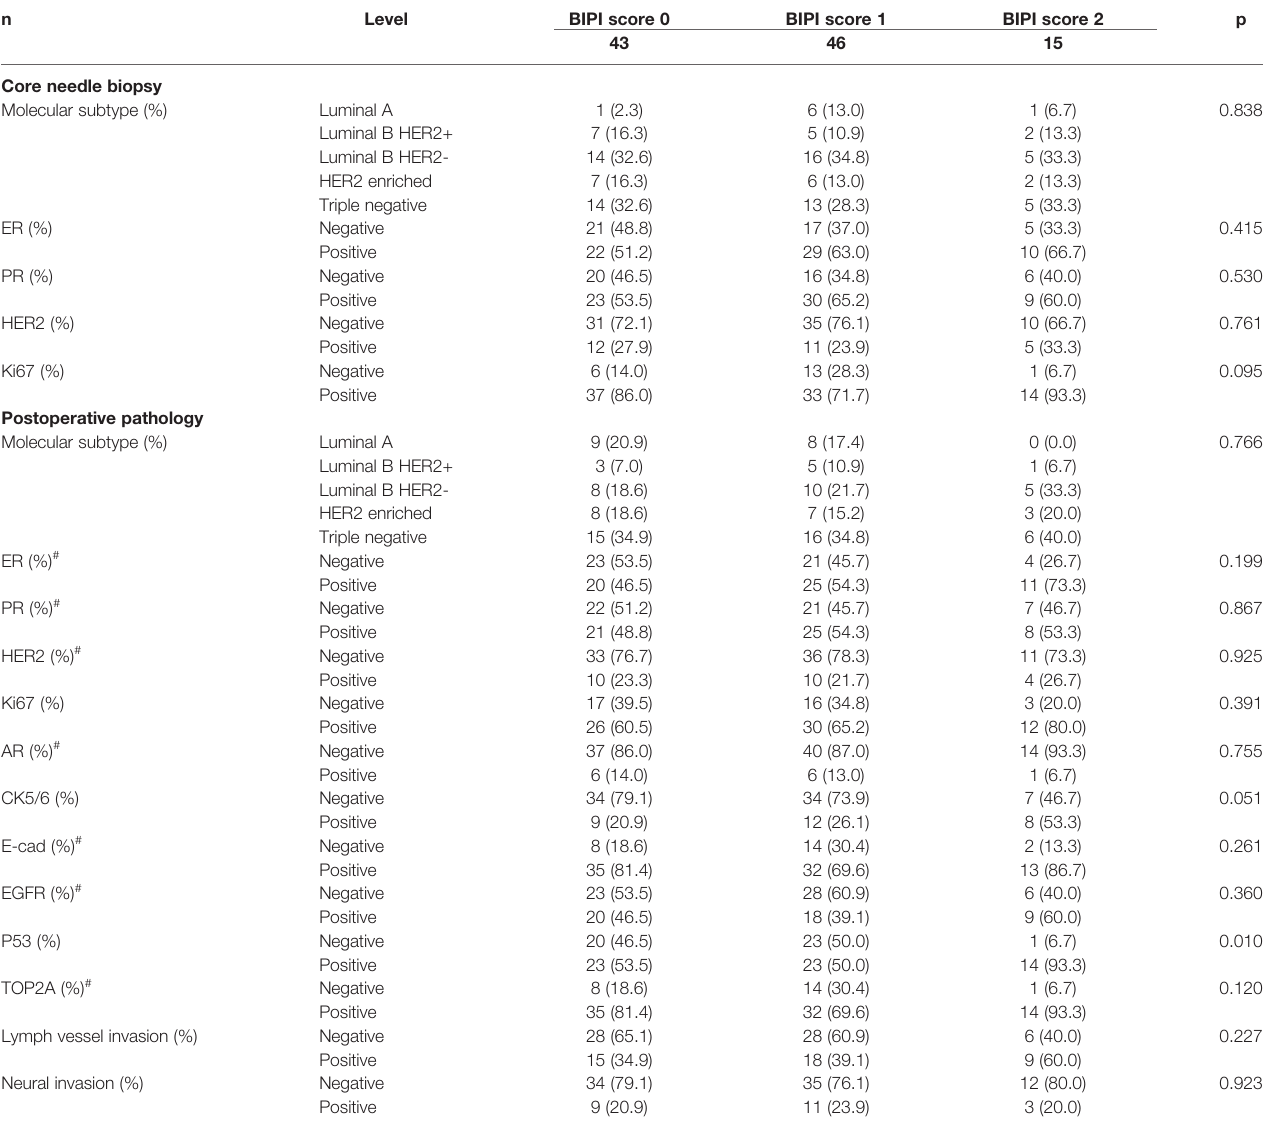
TABLE 2 | Patients ’ pathology parameters for all patients in accordance with breast immune prognostic index